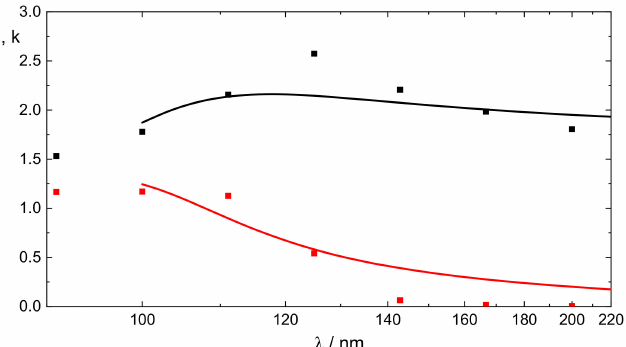
Figure 3. Refractive index (black) and extinction coefficient (red) of stoichiometric aluminum oxide (squares) and hypothesis used in our calculations (line).